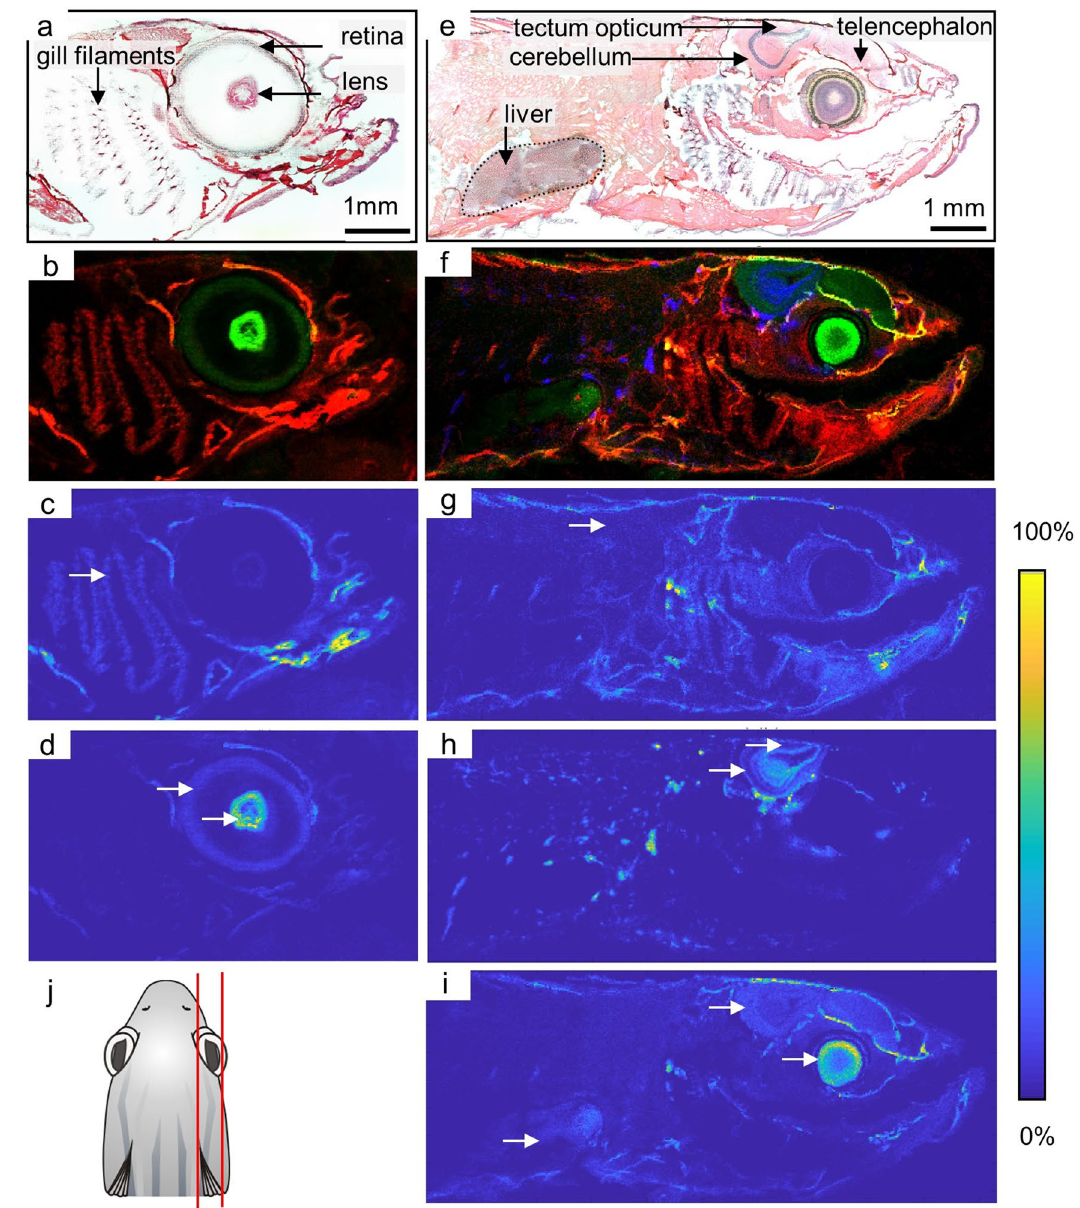
Figure 2. MALDI MS imaging of lipids in neuronal and non-neuronal compartments of D. rerio . ( a , e ) H&E (hematoxylin and eosin) staining of the sagittal cryosections in adult zebrafish showing detailed structures within the gills’ filaments, eye (retinae, lens), brain ( telencephalon, tectum opticum, cerebellum ) and liver. ( b ) RGB Overlay of PC (O-32:0) [M+H] + (red) and PC (30:0) [M+K] + (green). ( c , d ), ( g–i ) Positive ion mode MS images. ( c ) Ion image of PC (O-32:0) [M+H] + showing high intensity in the region of the gills’ filaments (white arrow). ( d ) Ion image of PC (30:0) [M+K] + visualizing the lens and the retina of the eye (white arrow). ( f ) RGB Overlay of PC (O-32:0) [M+H] + (red colored), PC (O-36:1) [M+K] + (blue colored) and PC (40:6) [M+H] + (green colored). ( g ) Ion image of PC (O-32:0) [M+H] + shows distribution with high intensity in non-neuronal tissue, exemplarily shown for muscle tissue (white arrow). ( h ) Ion image of PC (O-36:1) [M+K] + , illustrates the structural differentiation within the tectum opticum and parts of the cerebellum. ( i ) Ion image of PC (40:6) [M+H] + shows distribution within the brain and eye and presents the liver as relative homogenous tissue (white